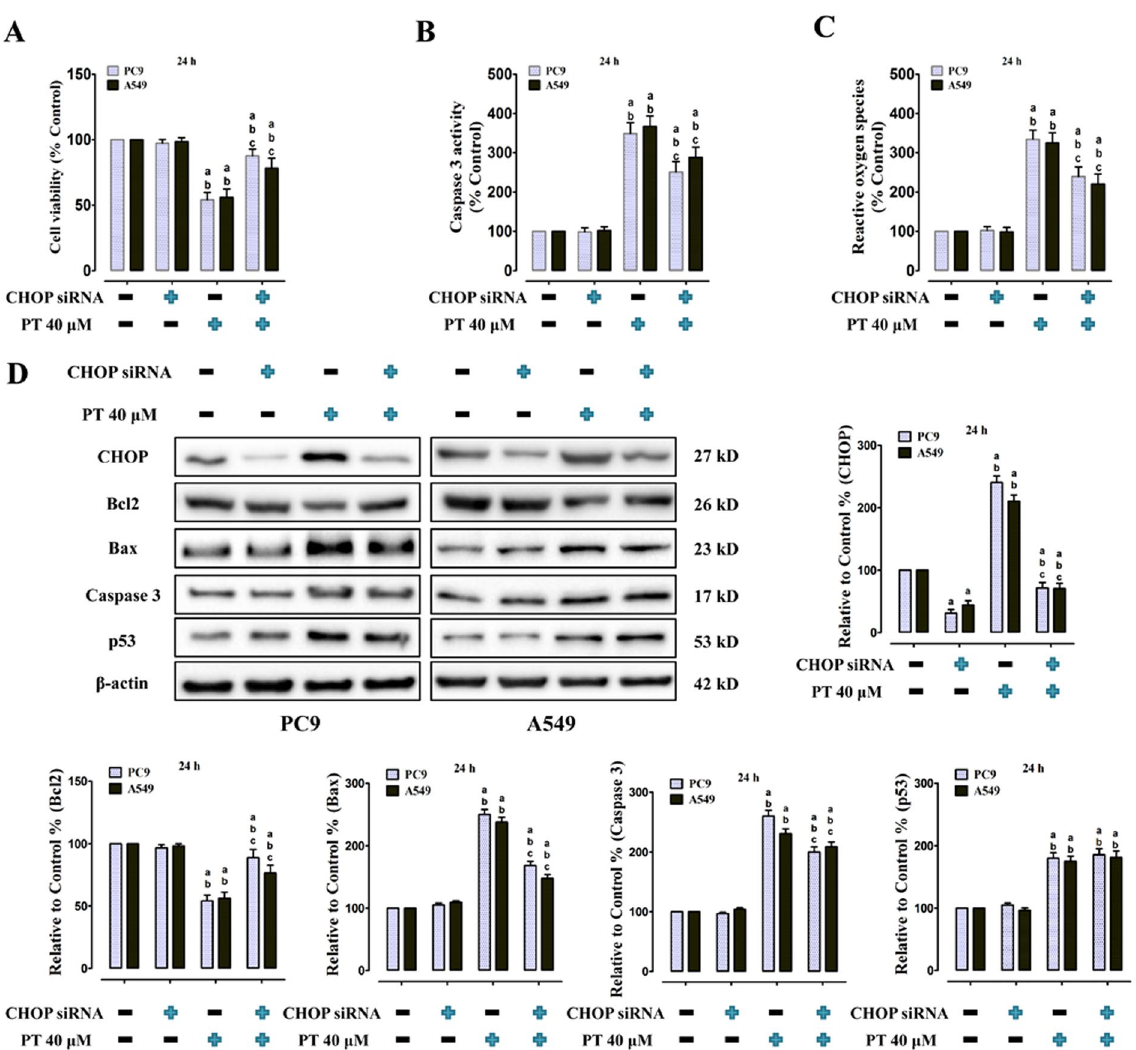
Figure 6. Effect of PT treatment combined with CHOP siRNA on cell viability, Caspase 3 activity, ROS generation, CHOP and apoptosis-related protein levels in PC9 and A549 cells (24 h). ( A ) Cell viability; ( B ) Intracellular Caspase 3 activity; and ( C ) ROS concentration were shown, and those three indexes in the control group were defined as 100%. ( D ) Representative western blot results of the key proteins, including CHOP, Bcl2, Bax, Caspase 3, and p53 were shown. Membranes were re-probed for β -actin expression to show that similar amounts of protein were loaded in each lane. The results were expressed as the mean ± SD; n = 6. a P < 0.05 vs . the control group, b P < 0.05 vs . the CHOP siRNA-treated group, c P < 0.05 vs . the Control siRNA + 40 μ M PT- treated